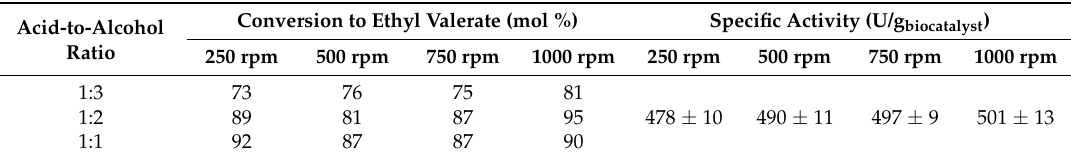
Table 3. Influence of stirring rate on the conversion of valeric acid to ethyl valerate and on the specific activity of prepared biocatalysts.